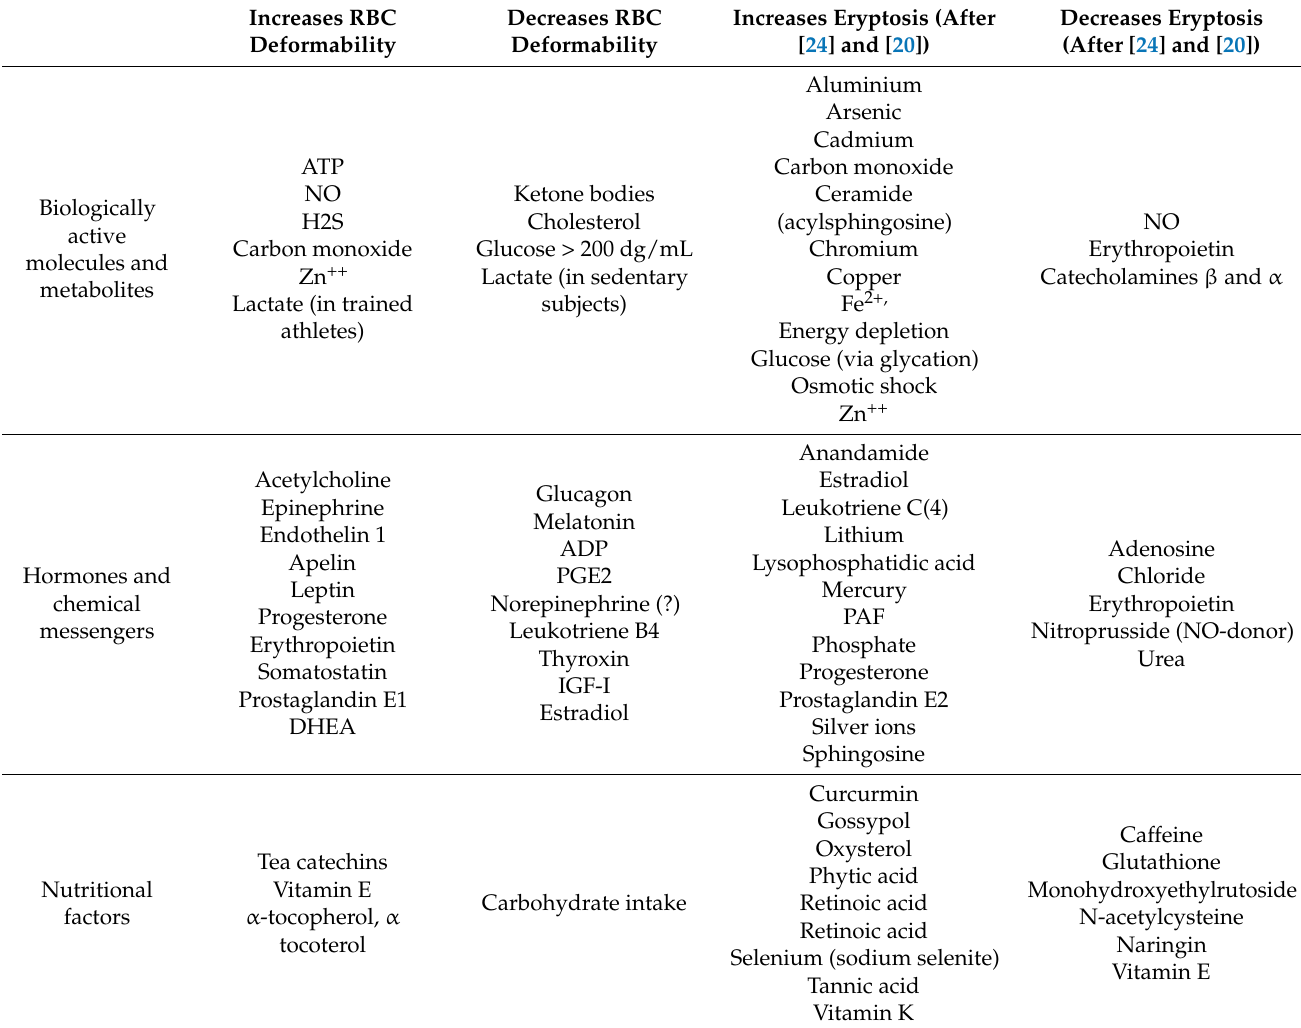
Table 1) triggers the process of programmed cell death in RBCs [46]. Table 1. Factors influencing red cell deformability and